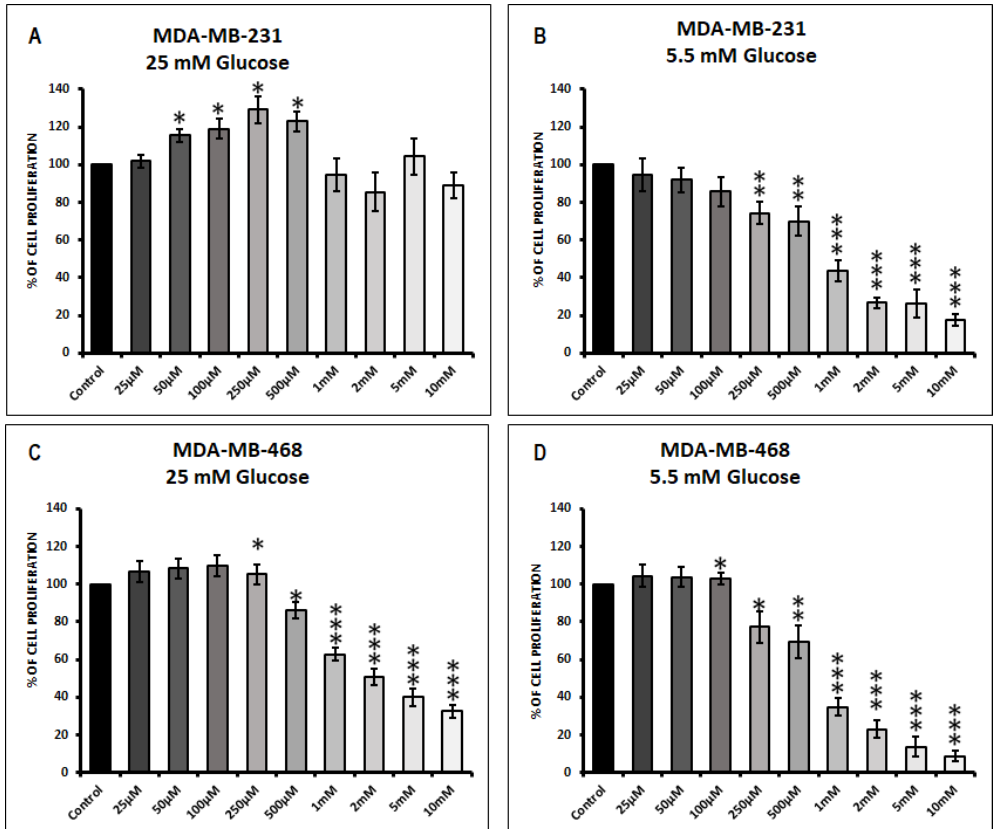
Figure 1. Response of MDA-MB-231 and MDA-MB-468 to 72 h treatment of metformin cultured in varying glucose conditions. Cell proliferation upon metformin treatment was measured using 3-(4,5-dimethylthiazol-2-yl)-5-(3-carboxymethoxyphenyl)-2-(4-sulfophenyl)-2 H -tetrazolium) (MTS) assay in ( A ) MDA-MB-231 cells at 25 mM glucose condition, ( B ) MDA-MB-231 cells at 5.5 mM glucose condition, ( C ) MDA-MB-468 cells at 25 mM glucose condition and ( D ) MDA-MB-468 cells at 5.5 mM glucose condition. Data represent the mean ± standard error of mean of 5–7 independent experiments. * p -value < 0.05, ** p -value < 0.01 and *** p -value < 0.001 was considered to be significant with respect